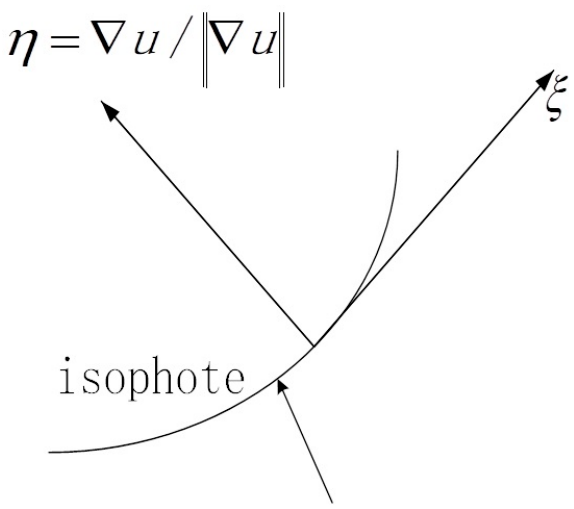
Figure 1. ξ and η denote the direction of perpendicular and parallel to ∇ u , respectively.